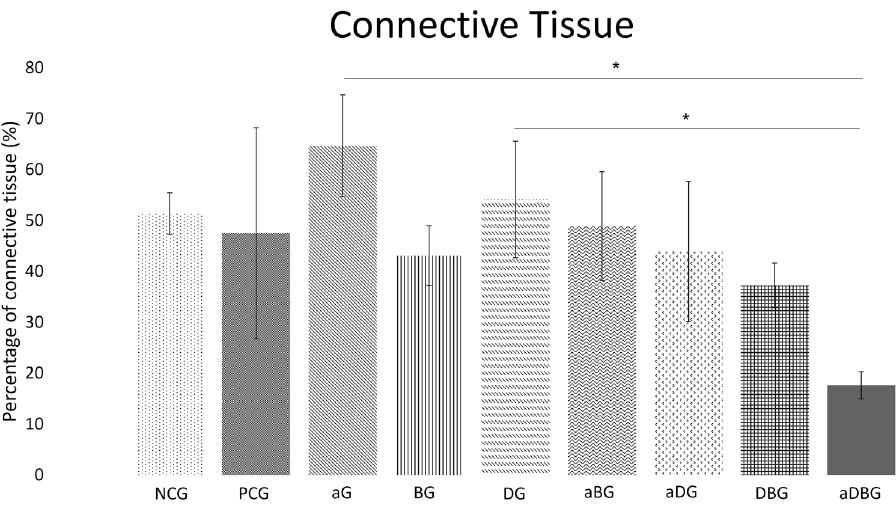
Figure 10. Graph representing the group-wise average percentage of connective tissue area. (*, p < 0.05) when compared to